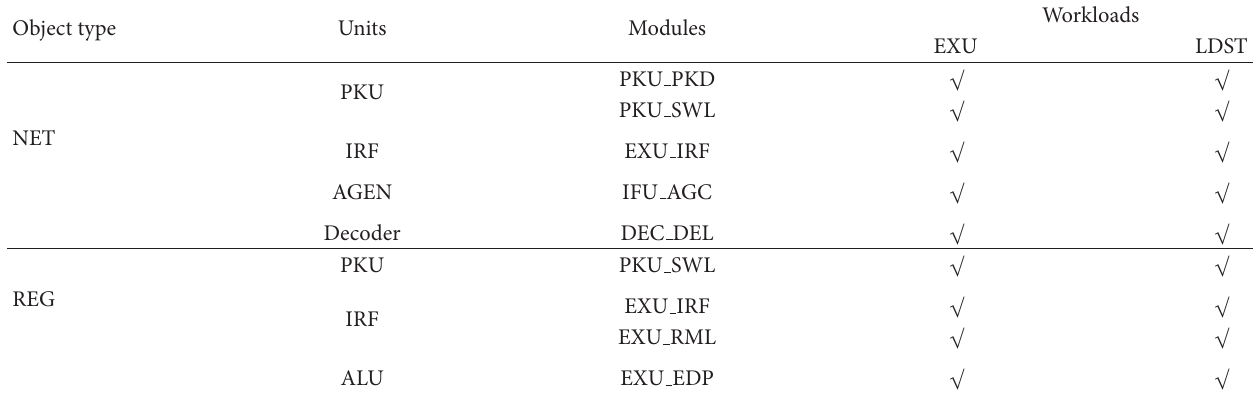
Table 7: Module level vulnerable